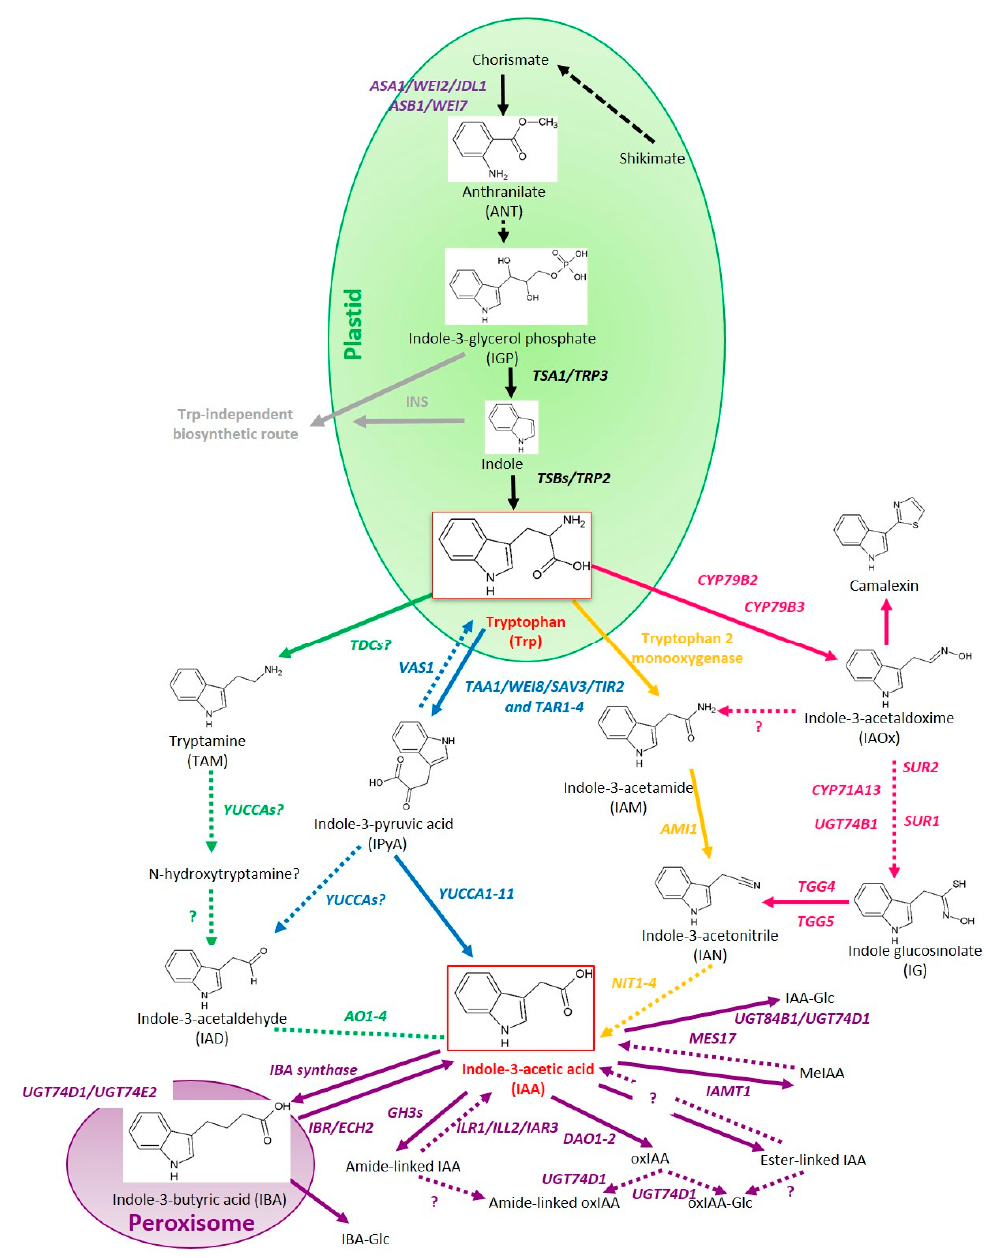
Figure 1. Auxin biosynthetic pathways in Arabidopsis thaliana . The IPyA pathway is shown in blue, the TAM pathway in green, the IAOx pathway in pink, the IAM pathway in yellow, the Trp-independent pathway in gray and the proposed metabolic pathways in purple. Enzymatic reactions without a known catalyzing enzyme are shown by dashed arrows. AO: aldehyde oxidases; IAA: 3-indole acetic acid; IAD: indole-3-acetaldehyde; IAM: indole-3-acetamide; IAN: indole-3-acetonitrile; IAOx: indole-3-acetaldoxime; IBA: indole-3-butyric acid; IG: indole glucosinolates; IGS : Indole-3-glycerol phosphate synthase; IPyA: indole-3-pyruvic acid; TAA1: TRYPTOPHAN AMINOTRANSFERASE OF ARABIDOPSIS 1 ; TAR1-4: TRYPTOPHAN AMINOTRANSFERASE RELATED 1-4 ; TAM: tryptamine; TRP: tryptophan; TSA1 : Trp synthase a; TSB : Trp synthase b; YUC1-11 : yucca genes encoding flavin-containing